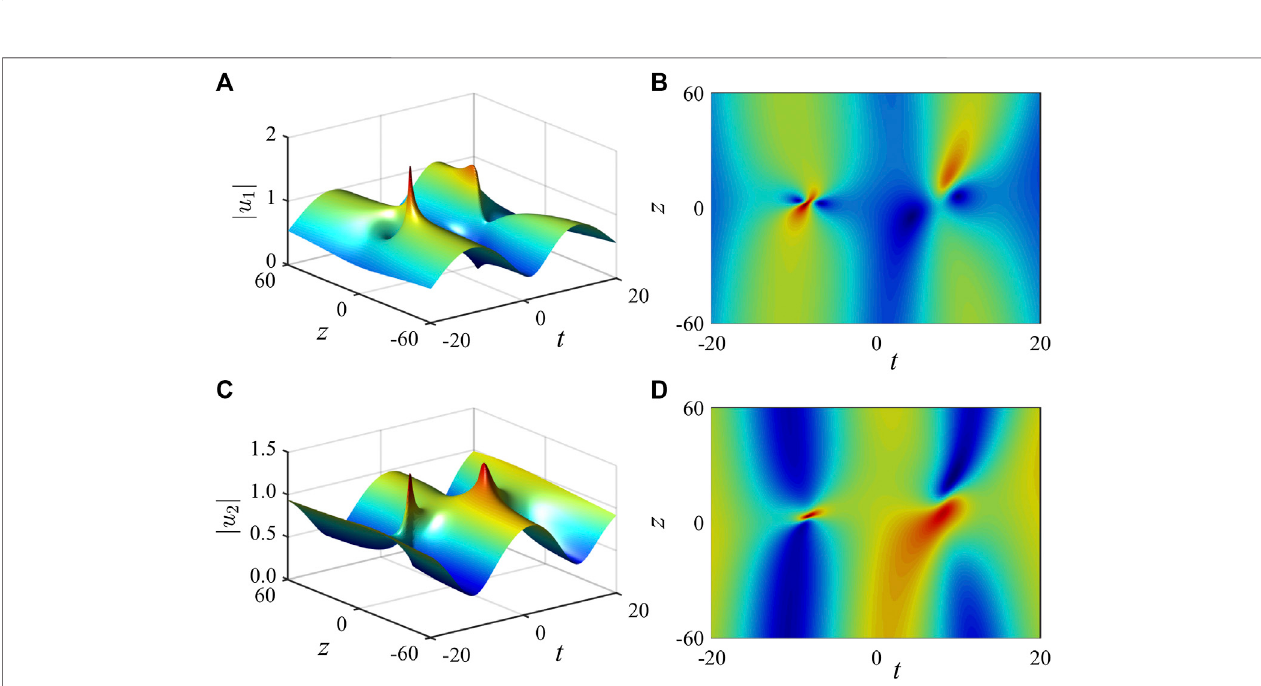
FIGURE 4 | Typical simulations of the periodic Peregrine soliton solutions ( Eq. 5 ) for given parameters σ (cid:2) 1, c (cid:2) 1 / 4, a 1 (cid:2) 8 / 9, a 2 (cid:2) 4 ω (cid:2) 40 / 81, μ (cid:2) − 4 / 9, and ] (cid:2) − 40 2 the self-steepening term being changed to i c ( 1 + 10% ) , respectively.